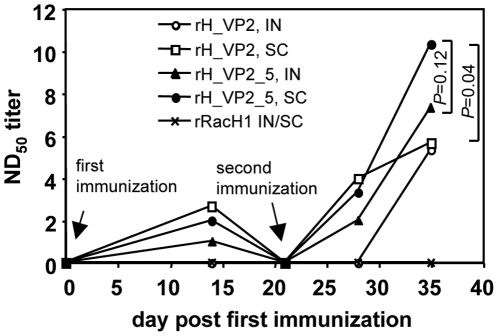
Neutralising antibody response was induced by the recombinant viruses.Three-week old female Balb/c mice were prime/booster immunised with rRacH1, rH_VP2 or rH_VP2_5. At the indicated days (0, 14, 21, 28, 35), mice were bled and the antibody was examined using standard serum neutralisation test. IN: intranasal; SC: subcutaneous.